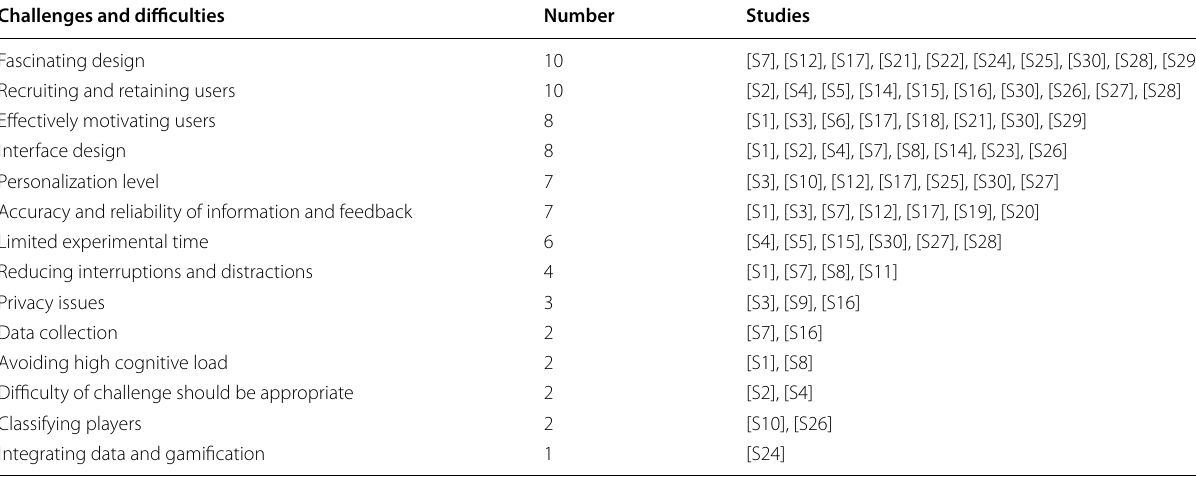
Table 12 Challenges and difficulties in implementing gamification Challenges and